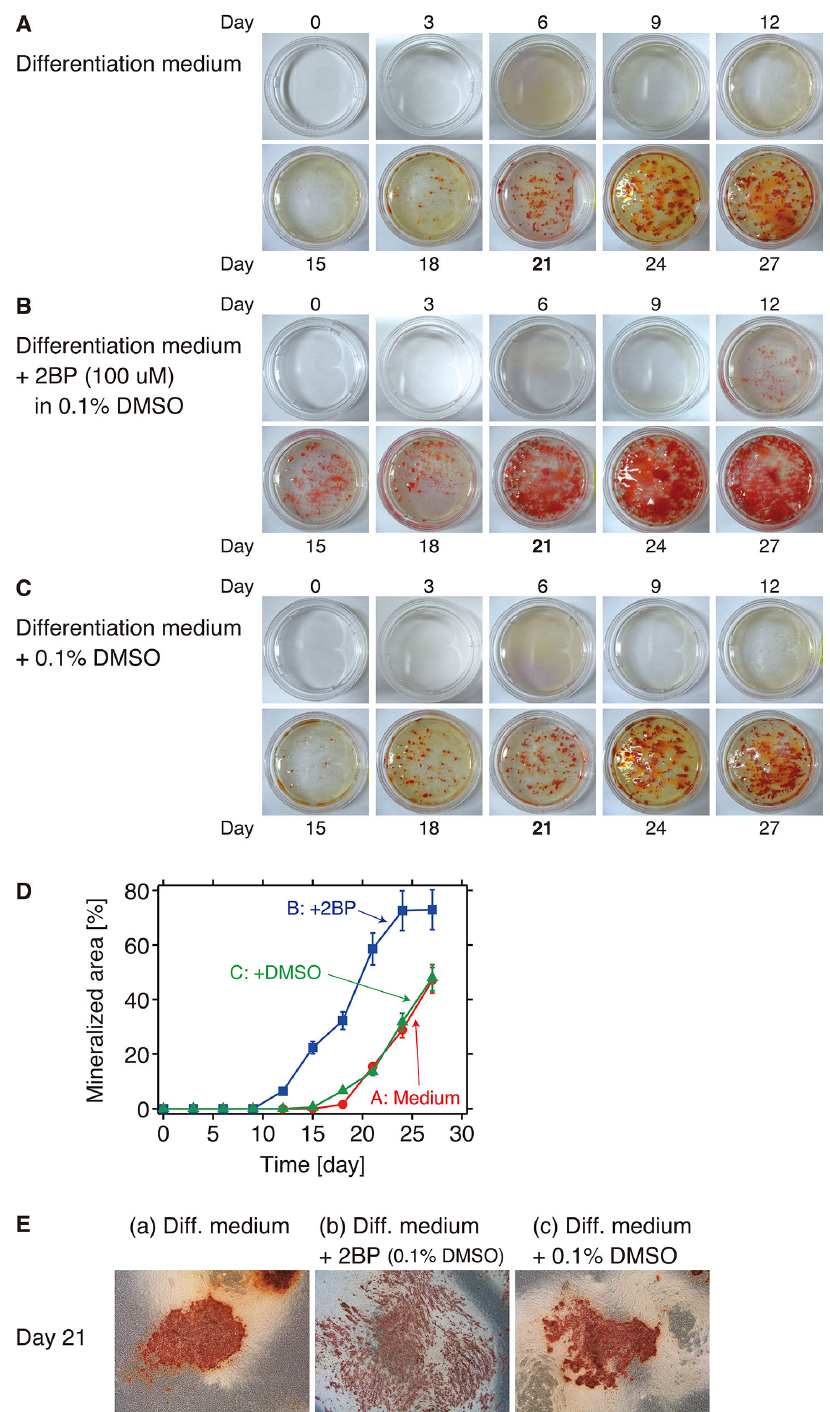
Figure 5. Bone nodule formation of osteoblast cells in the presence and absence of 2BP. A-C) Time-dependent bone nodule formation in the osteoblast cells A) in the absence of 2BP, B) in the presence of 2BP and 0.1% DMSO, and C) in the presence of 0.1% DMSO. The mineralized nodules are stained with Alizarin Red. D) The area occupied by the mineralized nodules (%) was plotted against the incubation time (day). Error bars indicate the standard error. E) Enlargement of the mineralized nodules on Day 21. In the presence of 2BP (panel b), the nodules were more diffuse (none were clustered) than in the other two conditions (panels a and c). On Day 0, the osteoblast cell differentiation was initiated. These experiments were carried out 3 times. doi: 10.1371/journal.pone.0075831.g005 PLOS ONE |